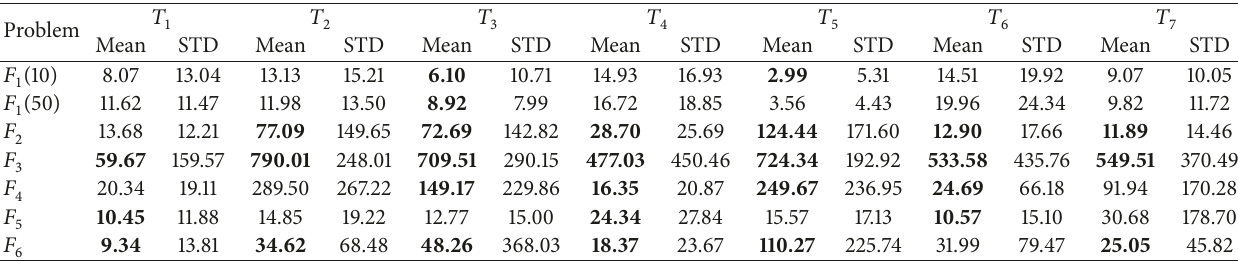
Table 5: Mean error values achieved for problems 𝐹 1 – 𝐹 6 by PLBA.